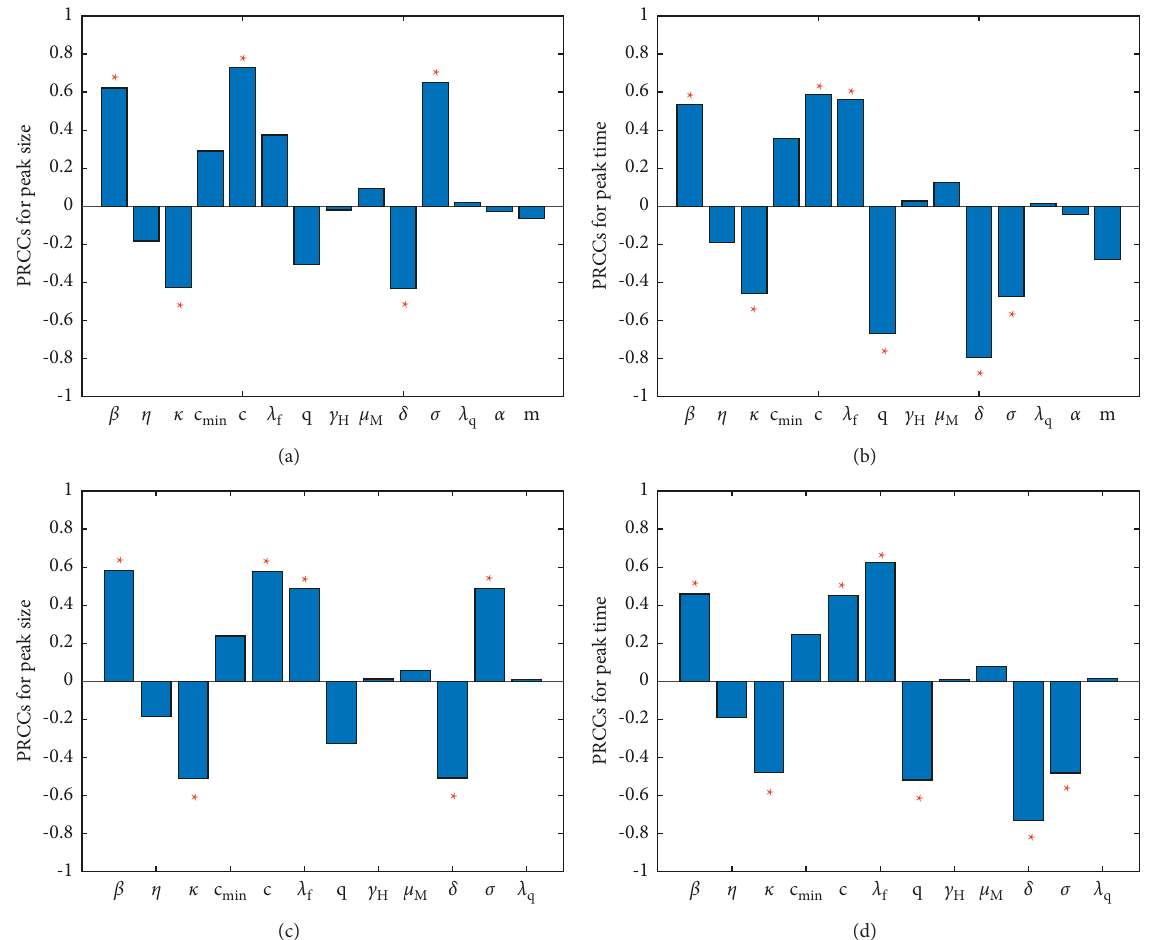
Figure 6: Sensitivity analysis of the peak size and peak time of the daily number of confirmed cases to the first ((a)–(b)) and second ((c)–(d))